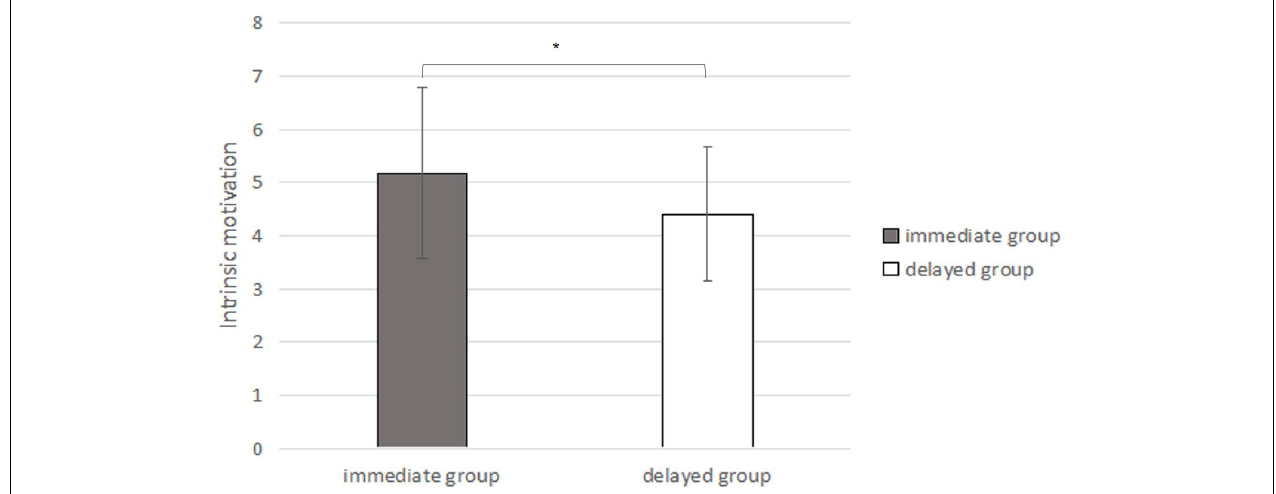
FIGURE 4 | IMI scores under the conditions of immediate extra rewards and delayed extra rewards (In the bar graph above, the error bars represent the standard deviations; ∗ represents p < 0.05).